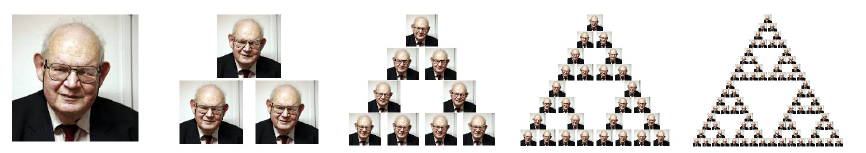
Figure 30. The first 4 copies of an input image generated by the MRCM of Figure